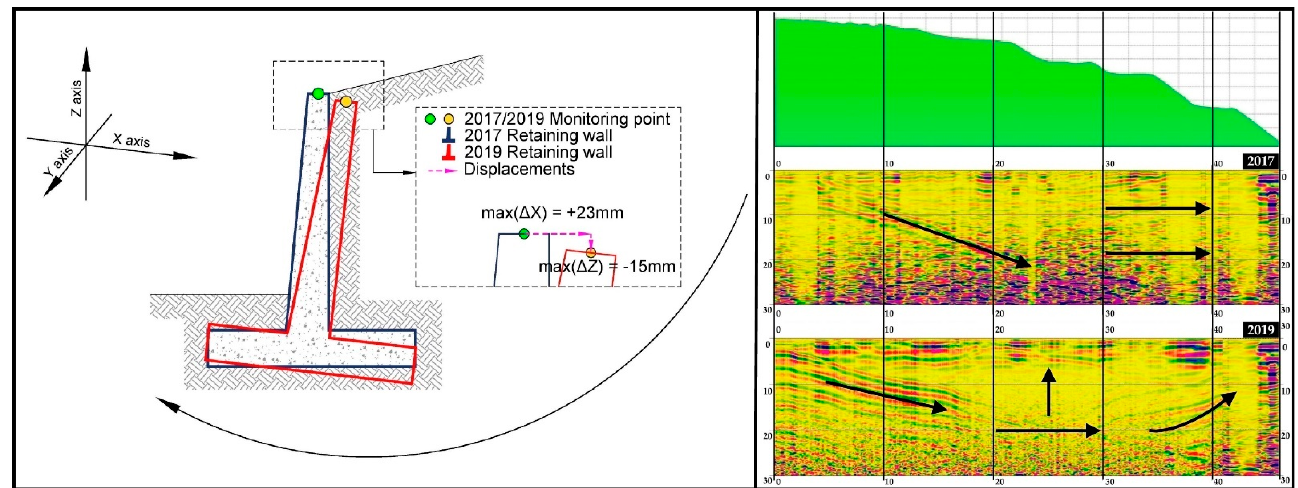
Figure 14. The retaining wall subjected to slight rotation due to overall slope instability, with the displacements and values highlighted; GPR longitudinal profiles show changes in the depth layers of soil and rock. Note: the rotation is slightly exaggerated inside the left figure in order to have a better visualization of the process. The values recorded are relatively small and do not possess danger in the near future.